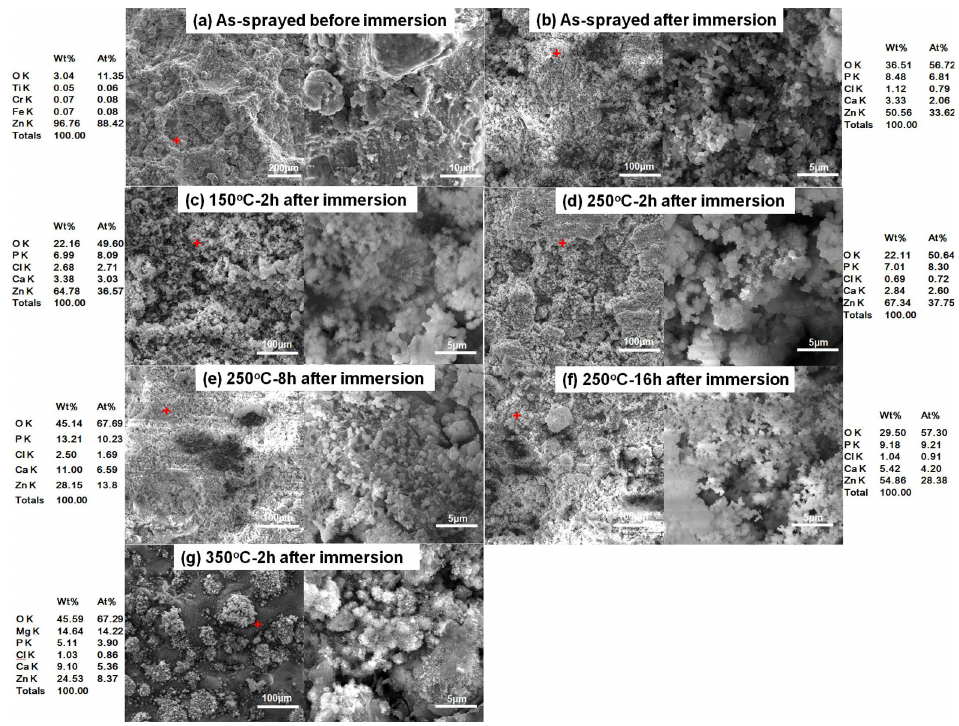
Figure 9. Surface morphologies of different Zn coatings after immersion for 14 days. Red plus sign: location for EDS.